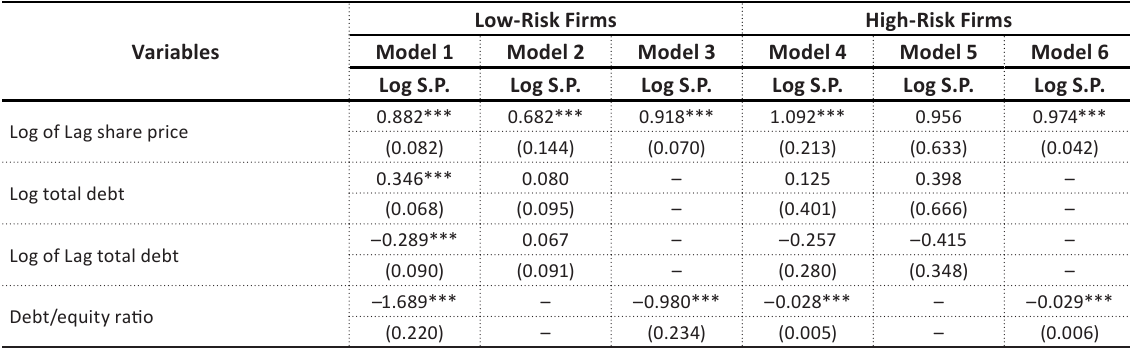
Table 4. Regression results for